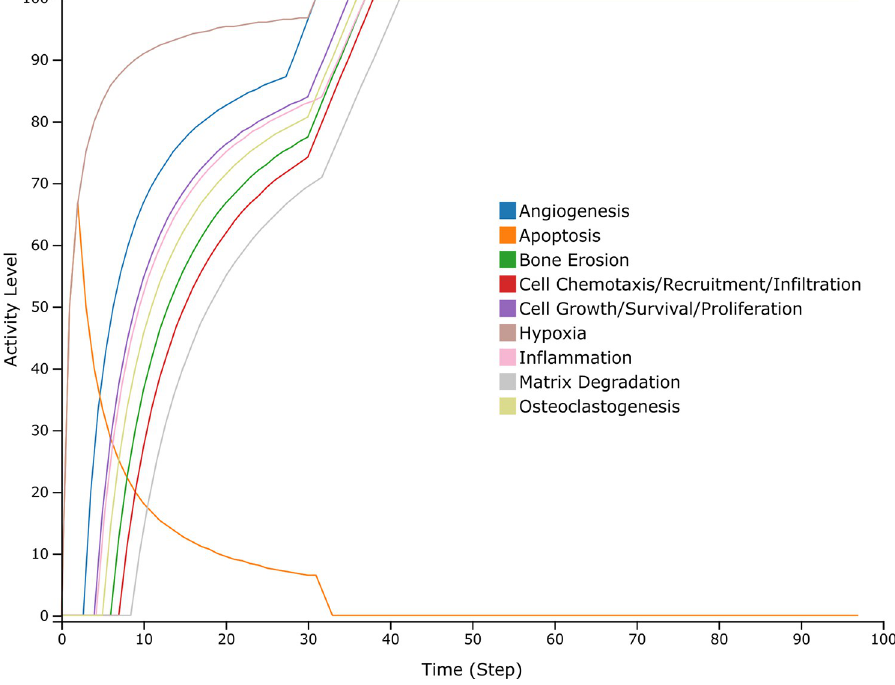
Fig 3. Simulation of the RASF model under RASF-specific initial conditions performed on the Cell Collective platform. The different curves depict the state of the phenotype components.